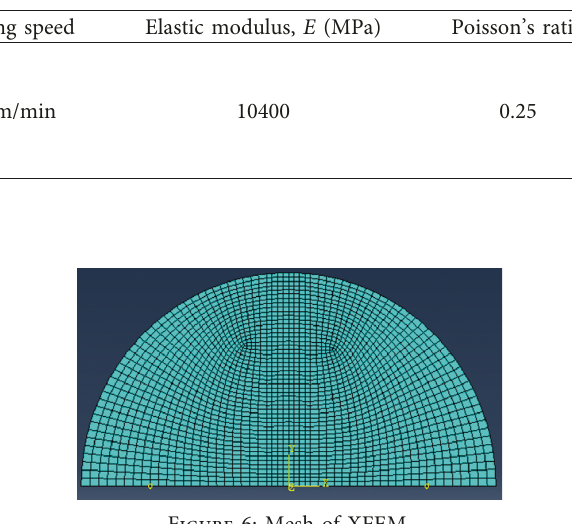
Figure 10: Comparing Figures 10 and 3(d), the expansion paths of the two diagrams are basically the same. The CIA calculated with the XFEM is 38 ° and 36 ° in the fracture test, which shows a good agreement. 4.1.5. M e 0. The calculation results are shown in Figure 11: (cid:31) Comparing Figures 11 and 3(e), the crack expansion paths of the two diagrams are basically the same. The CIA calculated by the XFEM is 50 ° and 51 ° in the fracture test, which shows a good agreement.